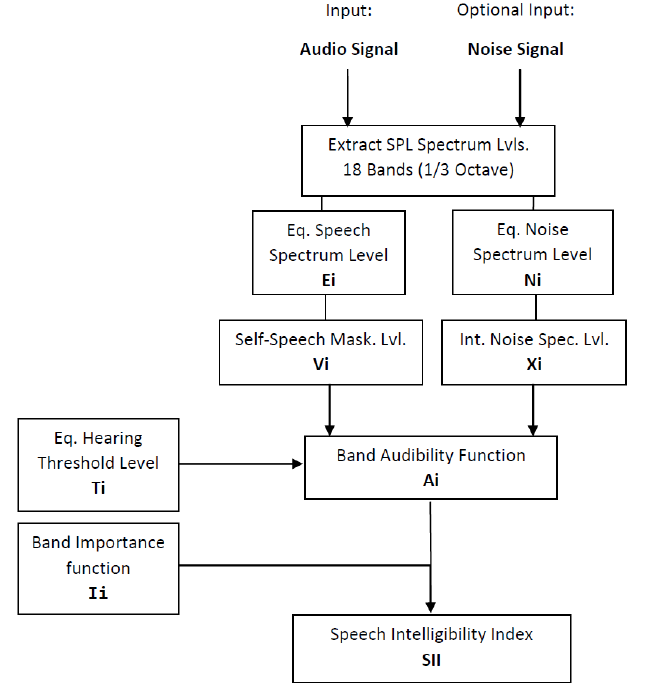
Figure 5. Block diagrams of the SII calculation algorithm defined in ANSI S3.5-1997.